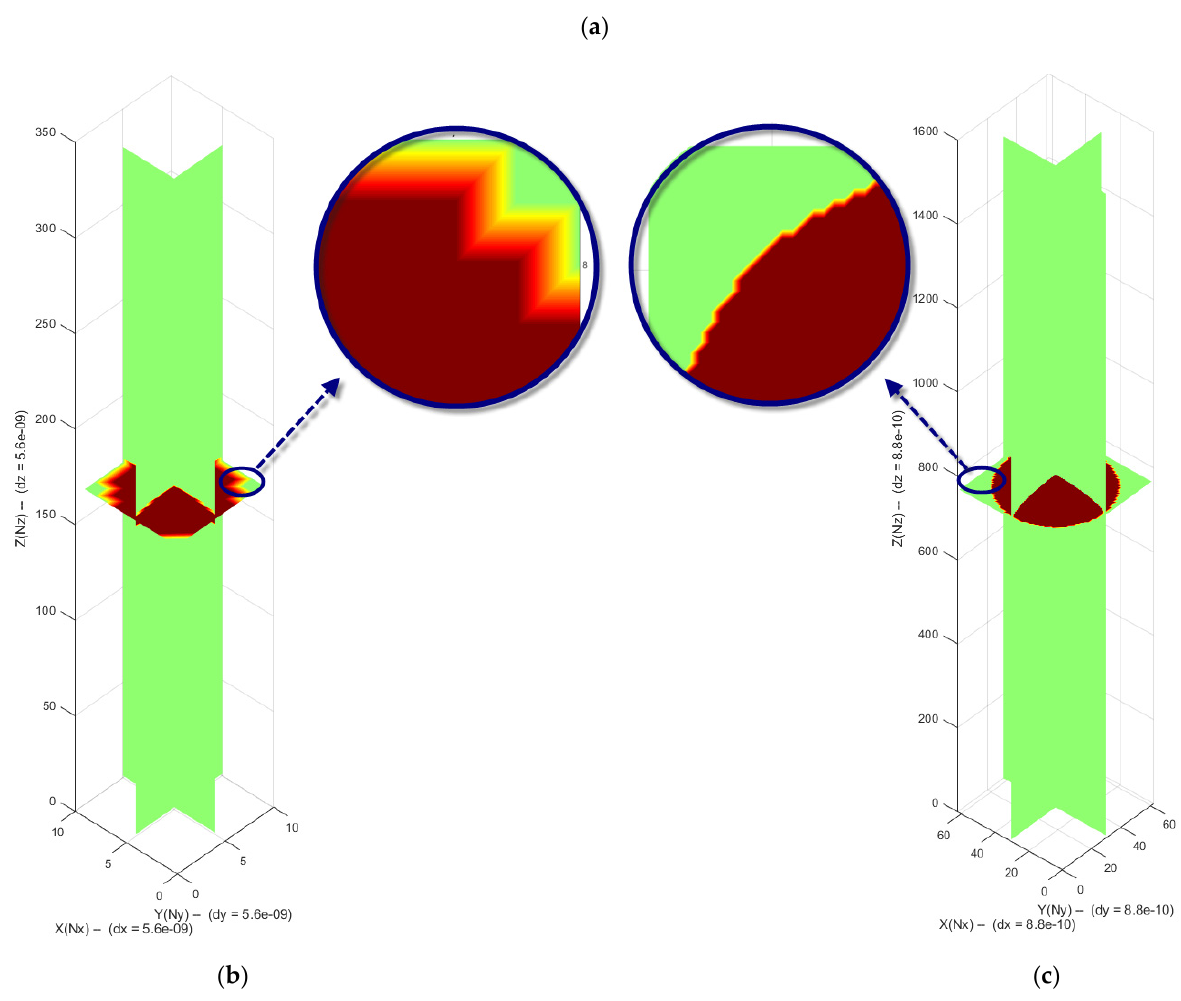
Figure 2. ( a ) SEM image of synthesized Ag NP in water [43]. 3D Cross-section view of a modelled Ag NP in: ( b ) FDTD Yee grid: ∆𝑑 = 5.56 nm total grid size of 28 × 28 × 330, as well as ( c ) OFDTD Yee grid: ∆𝑑 = 0.877 nm and total grid size of 62×62×1530.